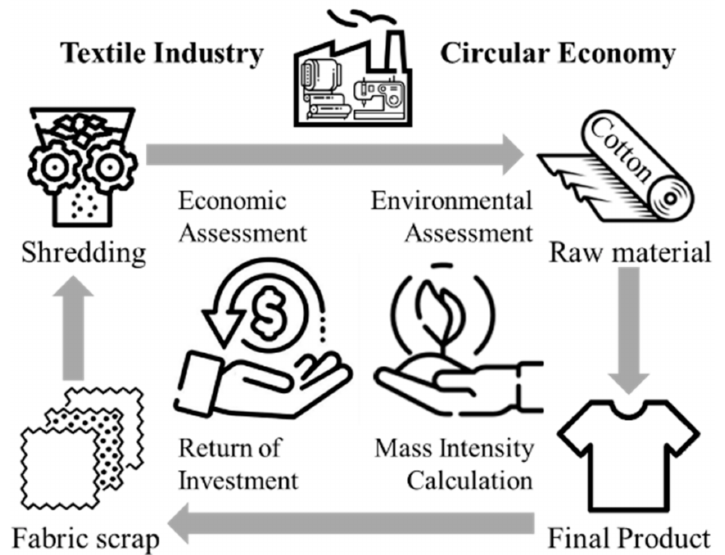
Figure 1. Proposed application of the circular economy in the textile